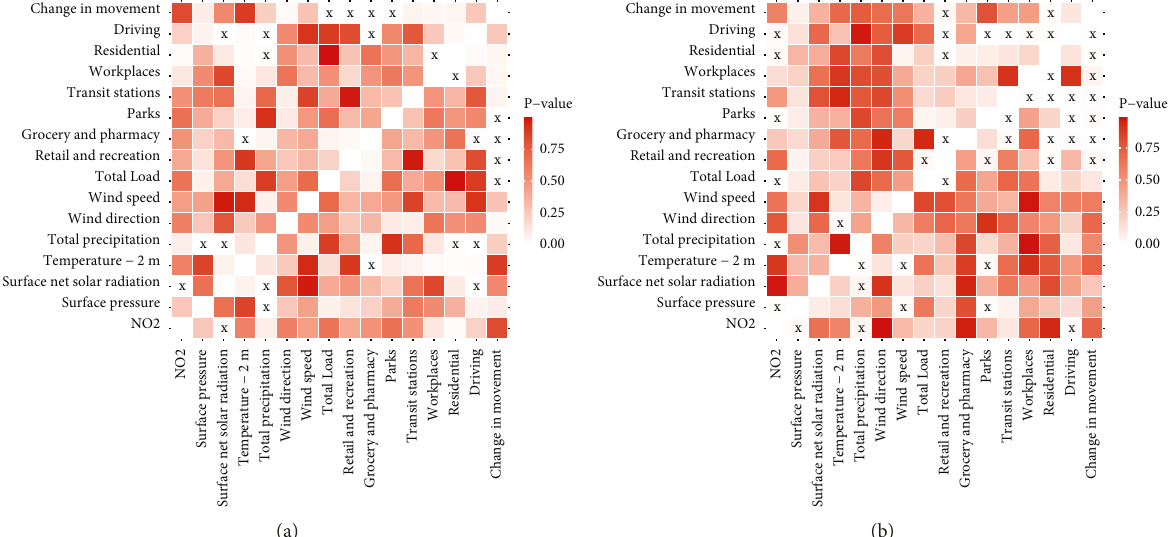
Figure 4: Connectivity matrices ( p values) and results of partial correlation and Granger